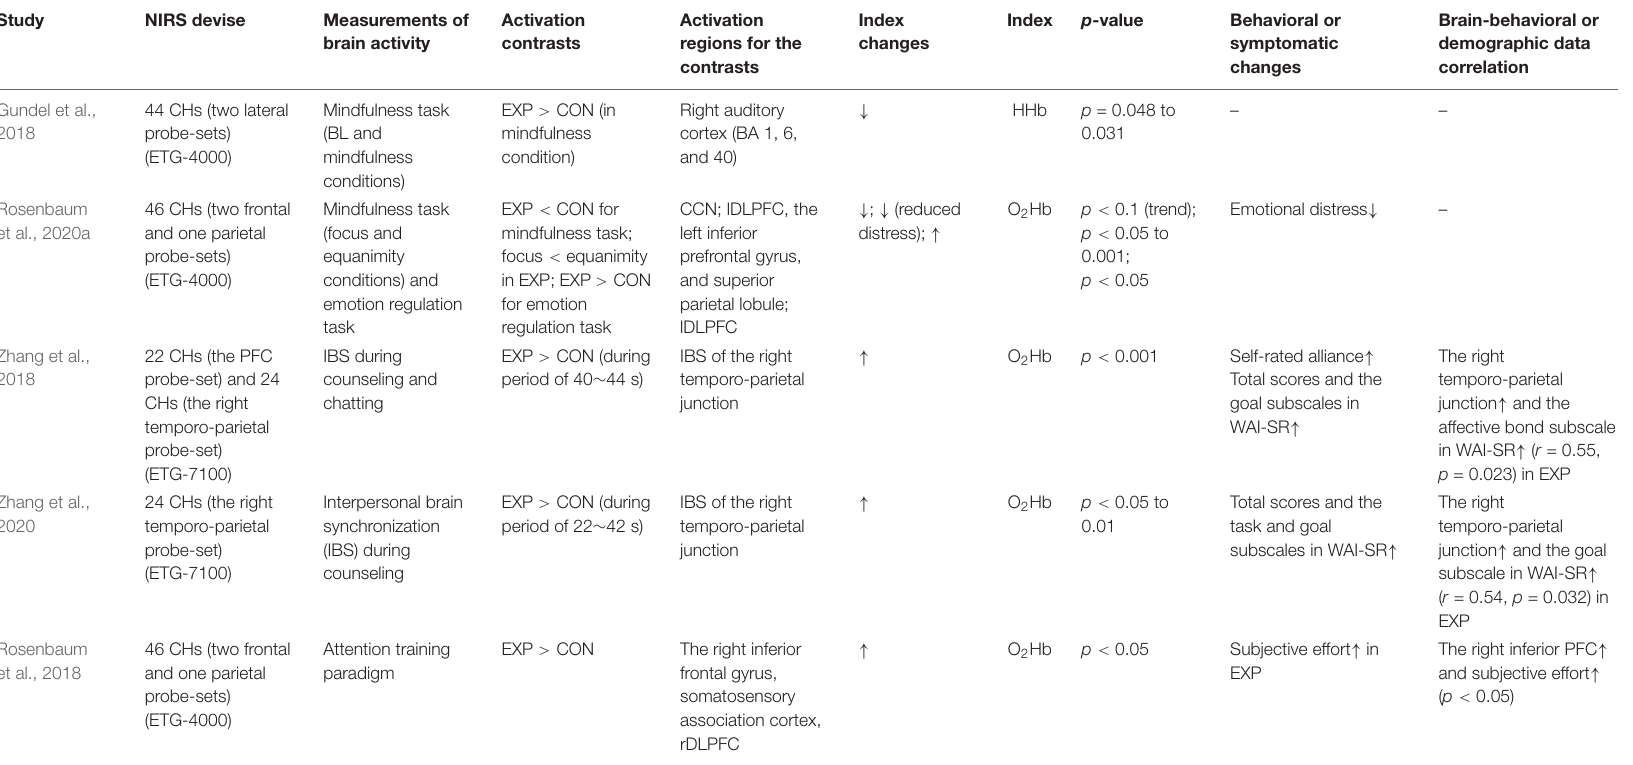
TABLE 2 | Brain and behavioral results of studies that evaluated psychotherapeutic effects using hemodynamic response changes.